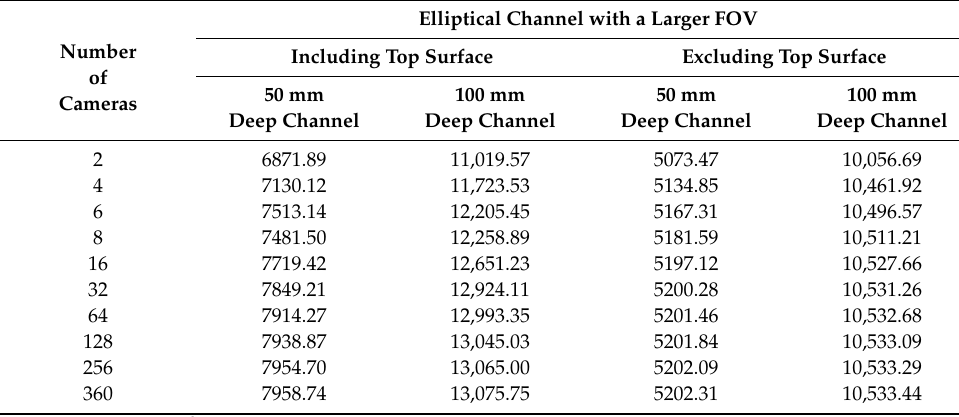
Table A3. Absolute values of the “elliptical channel” models with a larger